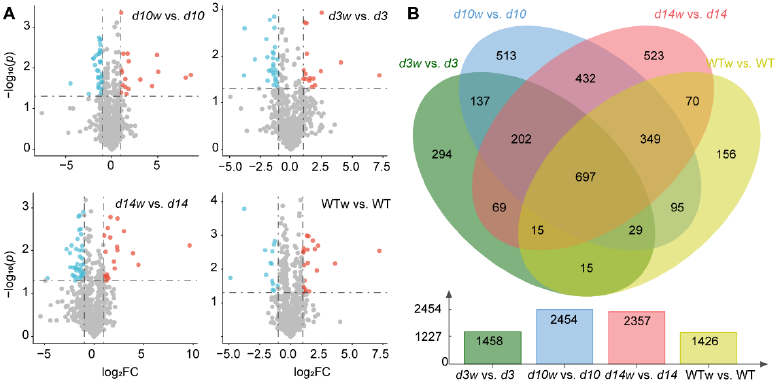
Figure 4. Schematic representation of differentially expressed genes (DEGs) between the mutants and wild type. ( A ) DEGs in the SLs mutants ( d3 , d10 , and d14 ) and wild-type plants. ( B ) Venn diagrams showing DEGs shared by the SLs mutants and wild-type plants. WTw, d3w , d10w , and d14w samples were collected 0.5 h after wounding.